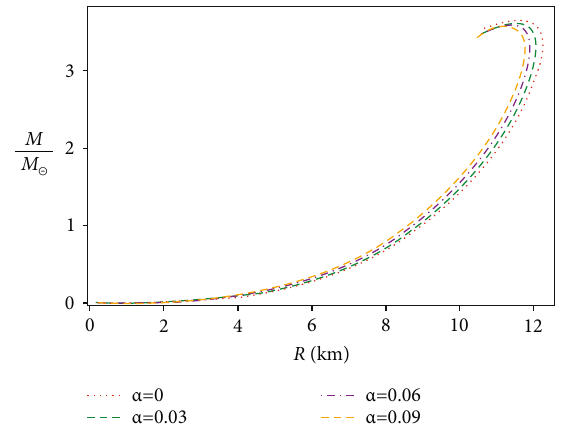
Figure 2: E ff ective mass-radius ð M − R Þ curve for the di ff erent strange stars having B = 83 MeV/(fm) 3 . The stars represented by g the M − R curve after it passes the maximum mass point are not stable.